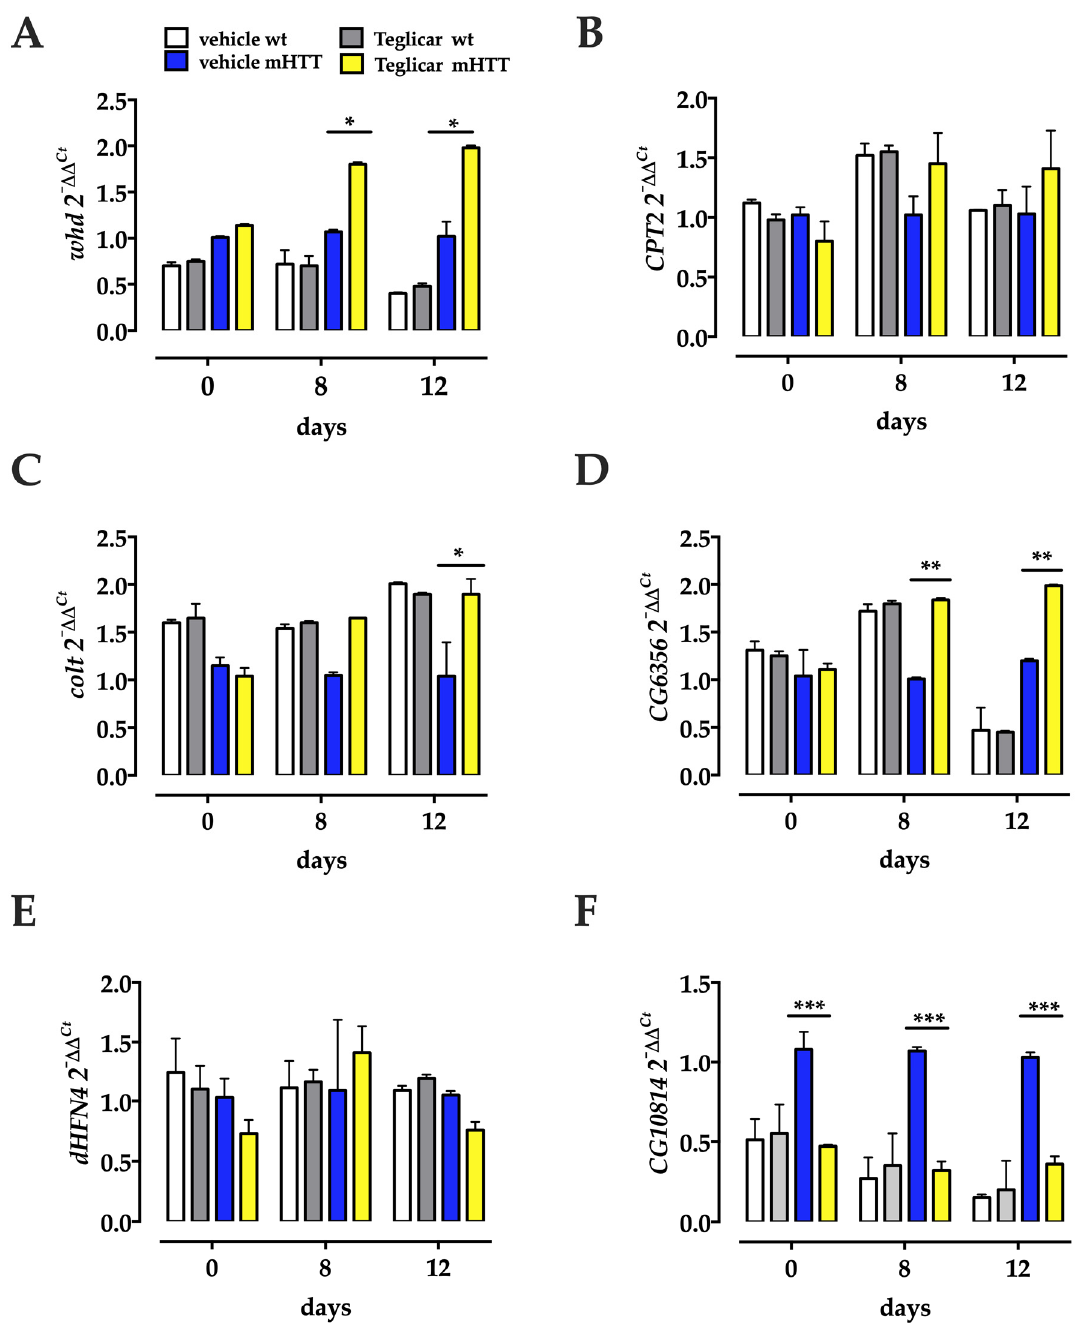
Figure 5. Heads transcriptional profiles of Drosophila carnitine cycle genes are altered by pharmacological inhibition of CPT1 activity. Two of the CS component genes are significantly overexpressed after Teglicar treatment at 8 and 12 days post-eclosion, whd ( A ) and colt ( C ), compared to the untreated control (vehicle mHTT). CG6356 ( D ) is upregulated compared to untreated controls (vehicle mHTT) at both 8 and 12 days post-eclosion, while CG10814 ( F ) is downregulated compared to untreated controls (vehicle mHTT) at days 1, 8, and 12 post-eclosion. CPT2 ( B ) and dHNF4 ( E ) remain unchanged at each time point examined. Relative gene expression was calculated with respect to the rp49 gene and control samples. Notably, for each gene, no transcriptional alterations were revealed between Teglicar-treated and vehicle-treated wt flies. (q)RT-PCR was performed on three different experiments, and the results are expressed as the mean of the values obtained (mean ± SEM). Sidak’s one-way ANOVA pairwise multiple comparisons test was used to calculate significance. * p < 0.05; ** p < 0.01; *** p < 0.001.